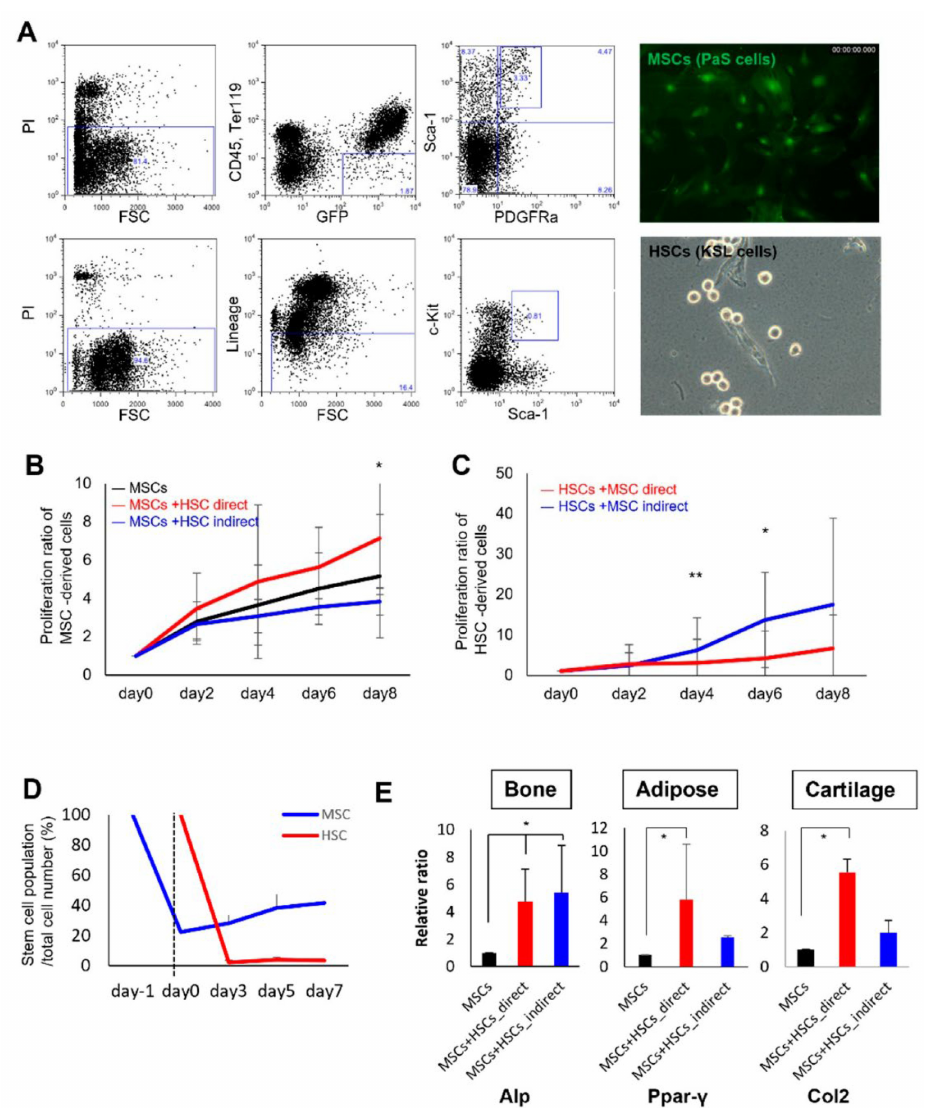
Figure 2. Clonal assay of MSCs after co-culture with HSCs. ( A ) Representative flow cytometric profiles of MSCs (upper, CD31 − , CD45 − , Ter119 − , Sca-1 + , and PDGFR- α + cells) and HSCs (bottom, c-Kit + , Lin − , and Sca-1 + cells). Microscopic views of MSCs (upper) and HSCs (bottom). ( B , C ) Cell proliferation of MSCs ( B ) and HSCs ( C ) 2, 4, 6, and 8 days after co-culture ( n = 6). * p < 0.05 and ** p < 0.01 between direct and indirect co-culture. ( D ) MSC and HSC population in whole mesenchy- mal and hematopoietic cells. MSCs were sorted on day − 1, and we waited until they attached to the bottom of the dish on day 0. After co-culture of MSCs and HSCs for 3, 5, and 7 days, cells were collected, sorted based on EGFP expression, and both cell types were detected using stem cell markers by flow cytometry. ( E ) Real-time PCR analysis of mesenchymal lineage marker expression in MSCs following a 3-week treatment with mesenchymal differentiation media after co-culture with HSCs ( n = 5). * p < 0.05 vs. MSCs